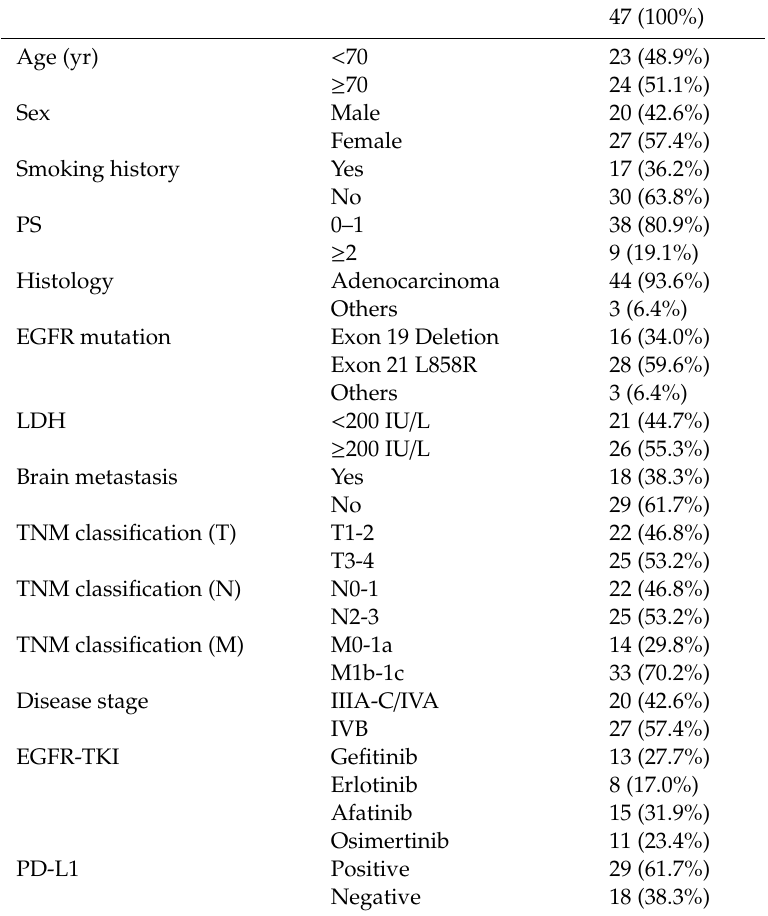
Table 1. Patient